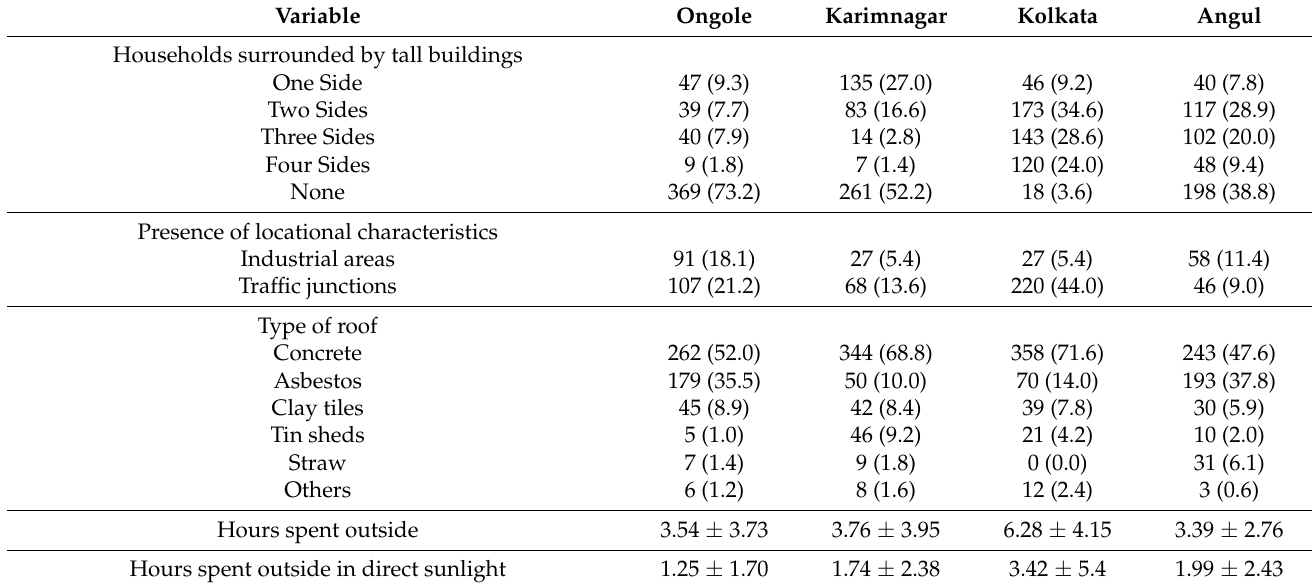
Table 3. Descriptive Statistics: